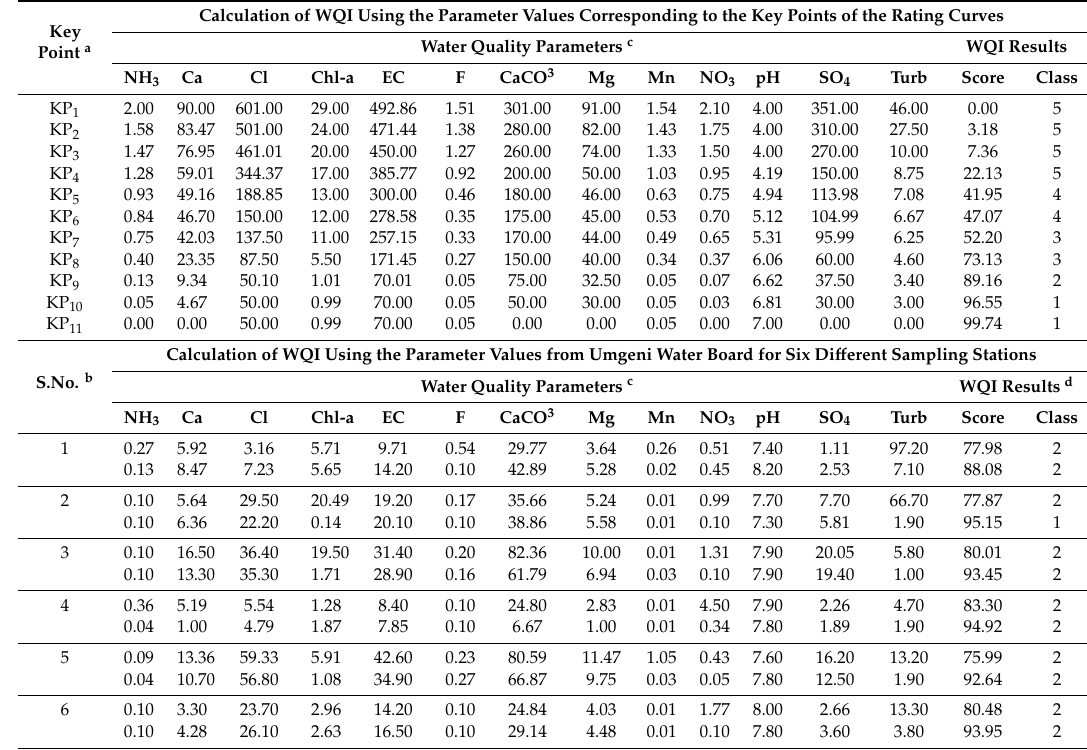
Table 6. Calculation of water quality index scores using universal water quality index (UWQI) model. Calculation of WQI Using the Parameter Values Corresponding to the Key Points of the Rating Key Point a